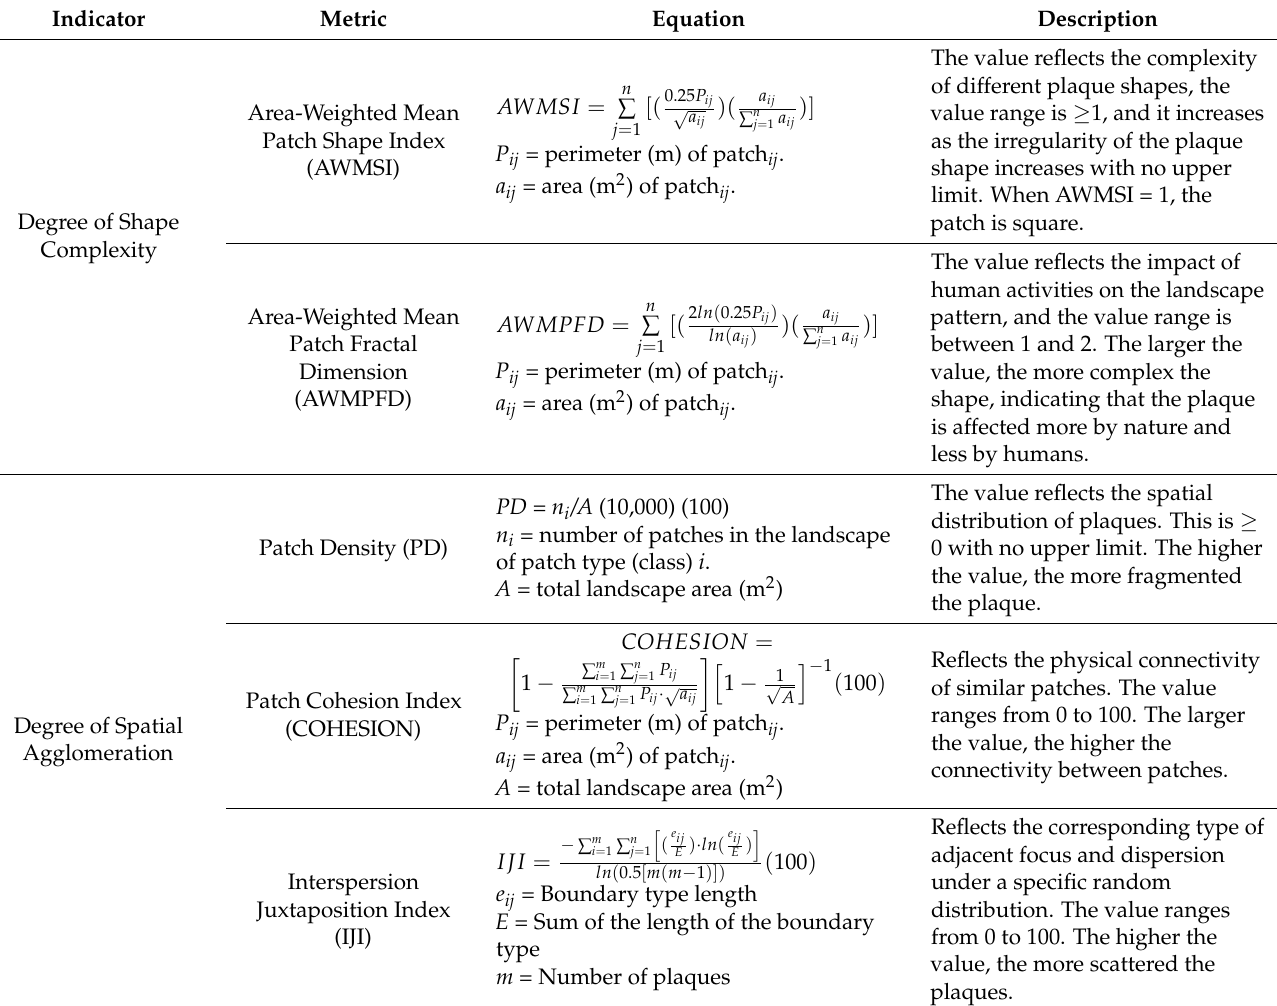
Table 1. The indicator system of the spatial distribution